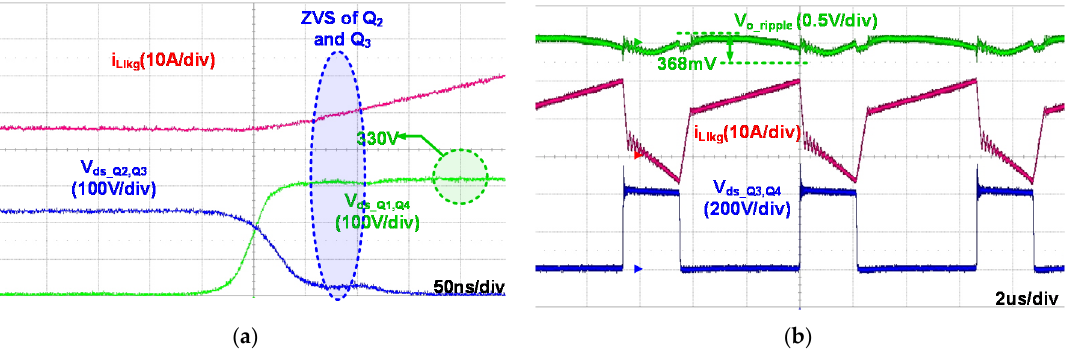
Figure 16. ZVS and output voltage ripple waveforms at worst case conditions. ( a ) ZVS waveforms at 310 V input and 100% load conditions. ( b ) Output voltage ripple waveforms at 200 V input and 100% load conditions. 88.088.589.089.590.090.591.091.592.092.593.0